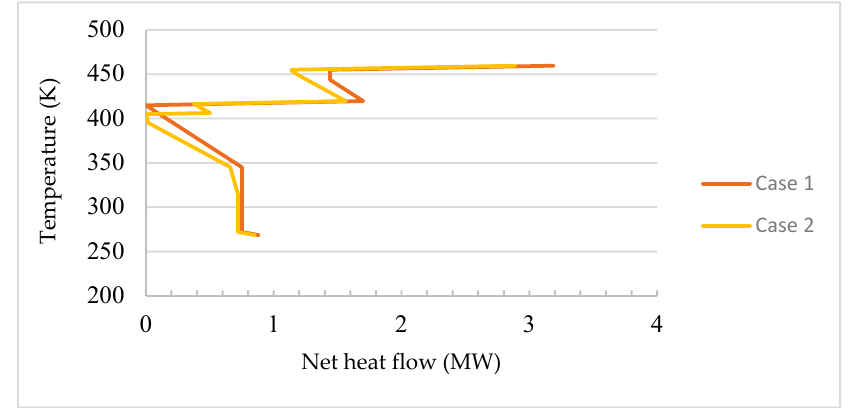
Figure 14. Grand composite curve (GCC) for case 1 and case 2.